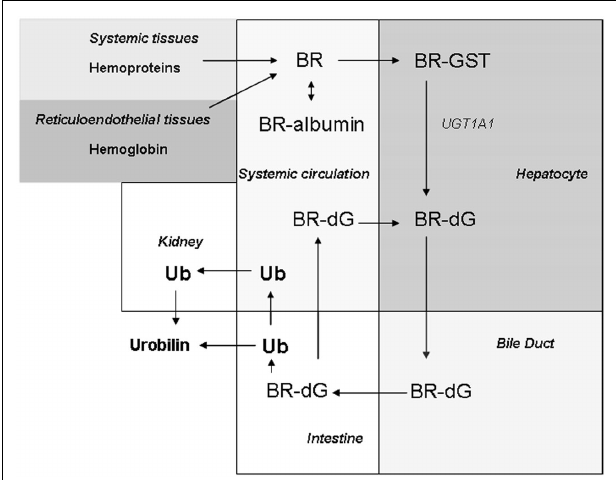
FIGURE 2 | Biodistribution of BR. BR is generated in systemic tissues as the product of hemoprotein (i.e., hemoglobin) degradation. BR formed in tissues passes freely to the circulation, where it exists mostly in a complex with serum albumin. BR is taken up by hepatocytes by facilitated diffusion. In the hepatocyte, BR is transported by glutathione- S -transferase (GST), and then conjugated by UDP-glucuronyltransferase-1A1 (UGT1A1) to form bilirubin di-glucuronide (BR-dG). Conjugated BR (BR-dG) is then pumped into the bile duct and reaches the intestine. Conjugated BR can be reabsorbed in the intestine and re-enter the circulation (Roy-Chowdhury et al., 2008;Vitek and Ostrow, 2009).The metabolism of BR in the intestine by bacterial action generates urobilinogen (UB) and its oxidation product urobilin, the latter which is eliminated in the feces. Intestinal urobilinogen can be reabsorbed by the intestine and eliminated in the urine as urobilin (Chowdhury and Chowdhury, 1983;Wang et al.,